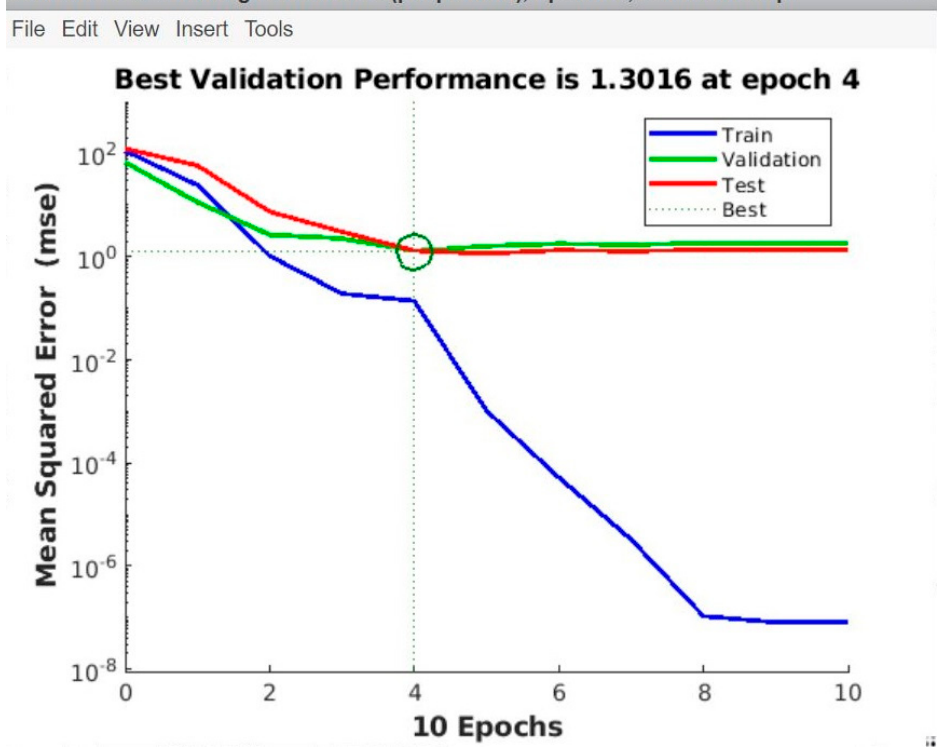
Figure 27 Validation Performance of the ANN Model. Figure 27. Validation Performance of the ANN